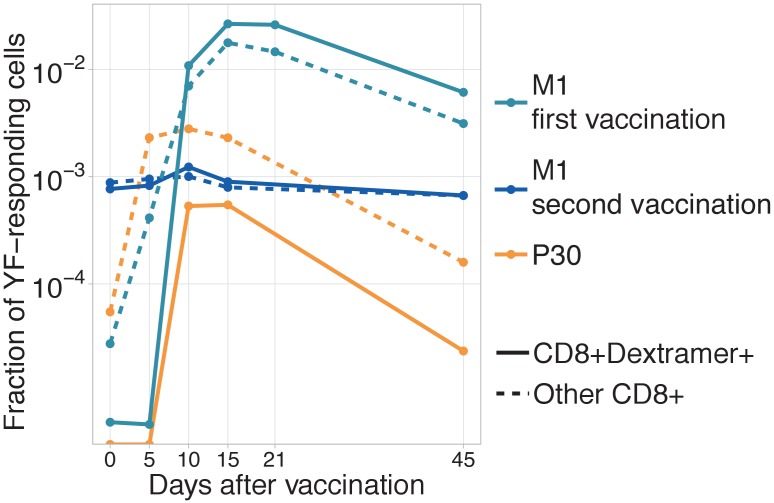
Dynamics of immunodominant response and other responses. Total frequency of YF-responding NS4B-dextramer positive (solid line) and other YF-responding CD8 clonotypes (dashed line) is plotted on different timepoints after immunization. All clonotypes are called YF-responding using edgeR. .